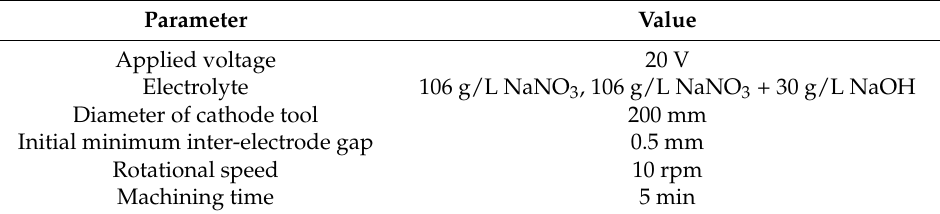
Table 1. Experimental parameters used in electrochemical machining (ECM).